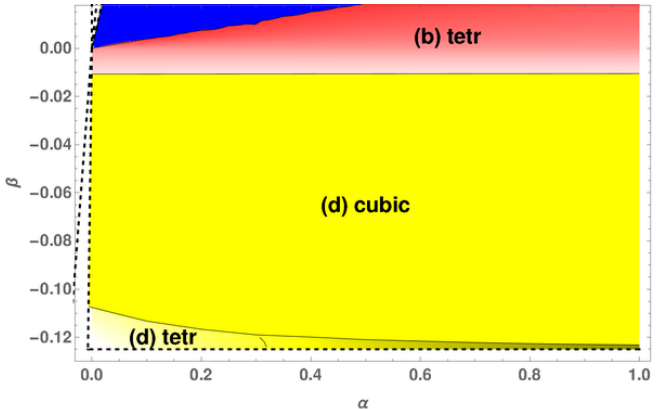
Figure 15: Zoom into the phase diagram for the non-Abelian crystals in the region of negative β